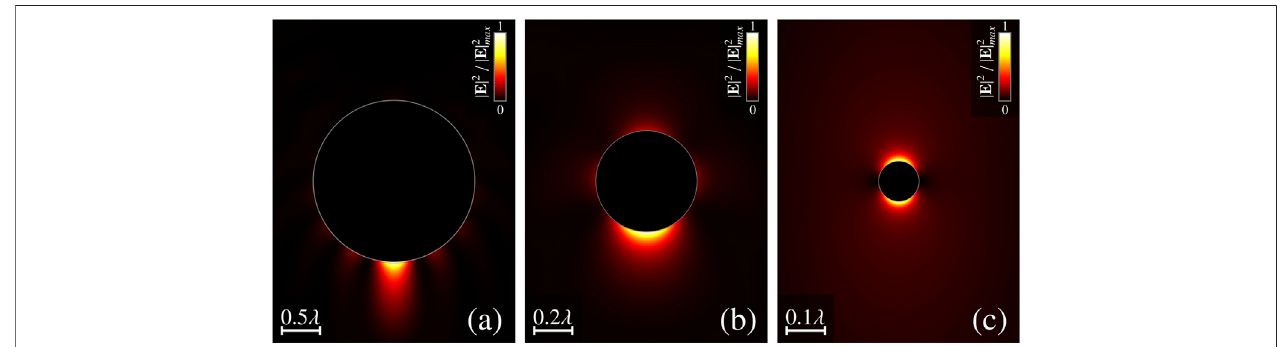
FIGURE6| Diffractiononthemetalsphericalparticle:near- fi eldintensitydistributionsinthe x - z plane.TheincidentwavearadialpolarizedGaussianbeam(LG 0,rad ). ϵ